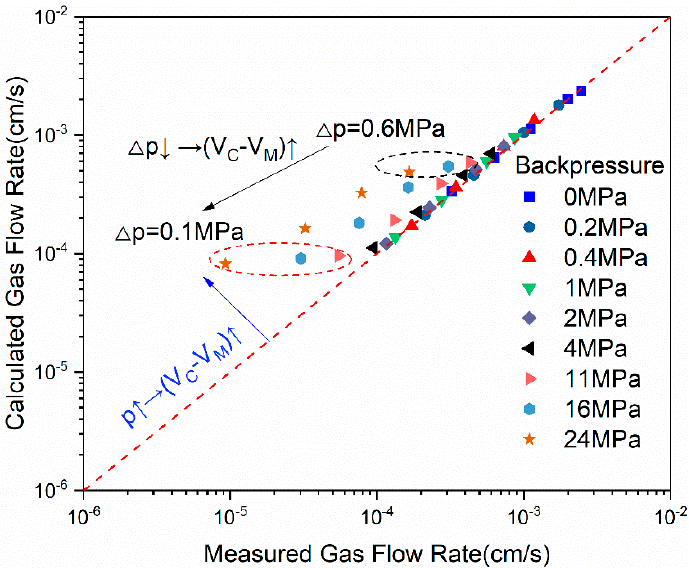
Figure 9. Measured flowrate versus theoretical flowrate at diverse backpressures for core Z2.